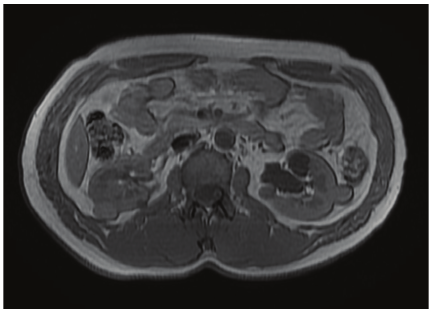
Figure 1: T1-weighted abdominal MRI in the axial plane demon- strating bilateral multiple renal masses of varying sizes and MR signal intensities.